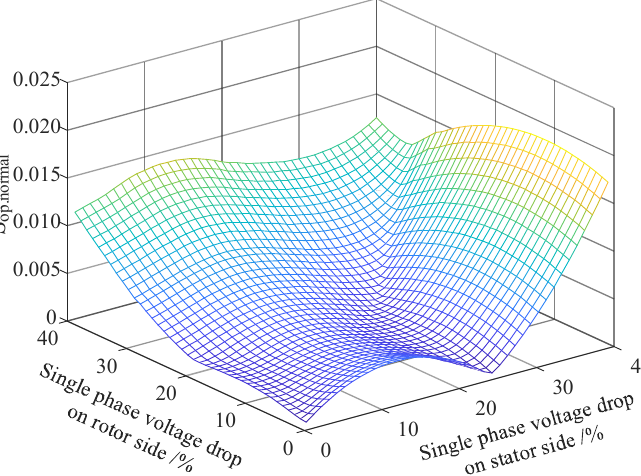
Figure 4. The action value S op . normal with different phase voltage drops when the slip ratio s is 0.01.